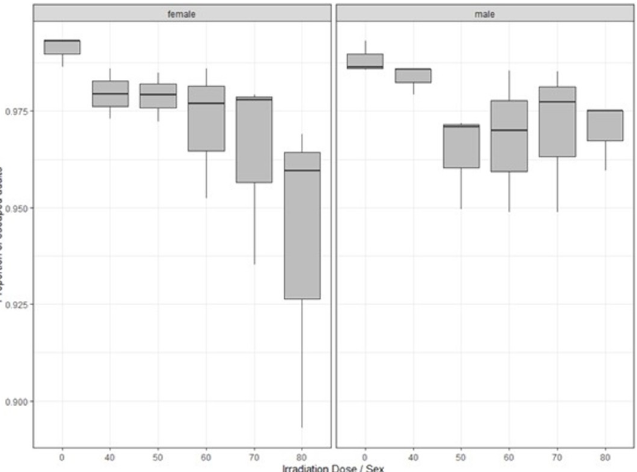
Fig 2. Effects of irradiation on flight ability of male and female Ae . aegypti following exposure to different irradiation doses. Each box denotes the median as a line across the middle, the quartiles (25 th and 75 th percentiles), the minimum and maximum values at the ends of the vertical lines. Results are expressed as mean ± SE.